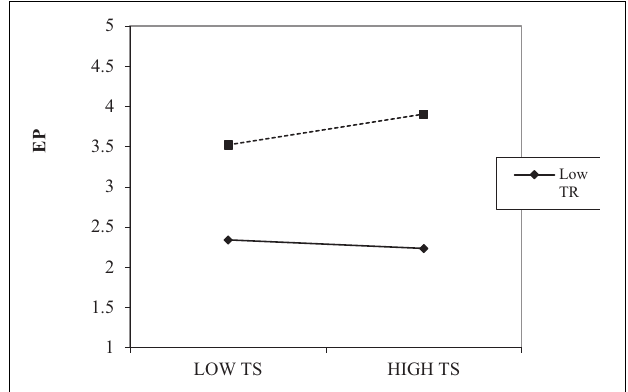
FIGURE 3 | Techno stress and training interaction plot. TS, Techno Stress; TR, Training; EP, Employee Performance.